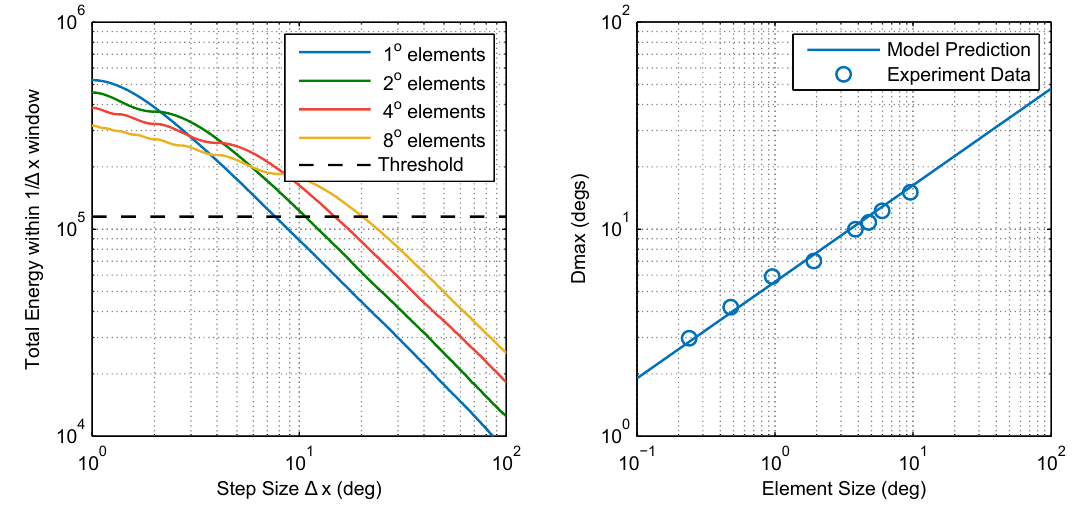
Figure 7. Simple motion energy-based model of Dmax in the praying mantis (Model 1). ( Left ) the total motion energy of unaliased pattern components contained within a frequency window ( [ − 1/ ∆ x ,1/ ∆ x ] ) decreases as the step size ( ∆ x ) is increased. Patterns of larger elements have a larger portion of their motion energy within lower frequencies and therefore contain more energy at large step sizes. According to this model, Dmax is the step size corresponding to a given motion energy threshold (chosen here to be ∼ 10 5 units); ( Right ) This simple model is in good agreement with our experimental results for the mantis (standard error of the regression, S = 0.613 ◦